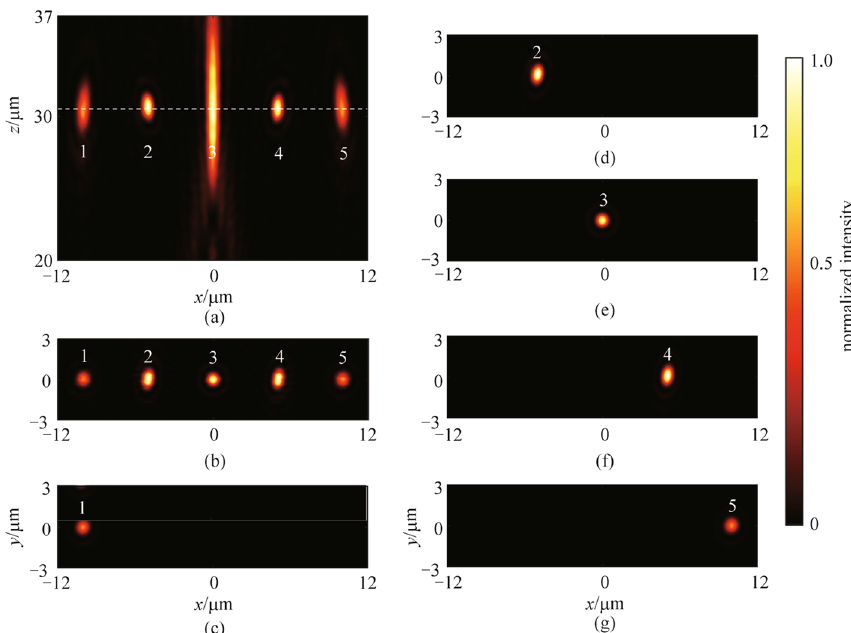
Fig. 5 Characterization of the metalens molecule for the x -LP light wave. a Normalized intensity distribution at the xz section. b Normalized intensity distribution at the focal plane when all the metalenses are illuminated. c – g Normalized intensity distributions at the focal plane when each target metalens is respectively illuminated. All the intensity distributions are normalized by the maximum intensity of the metalens mol- ecule designed for the x -LP